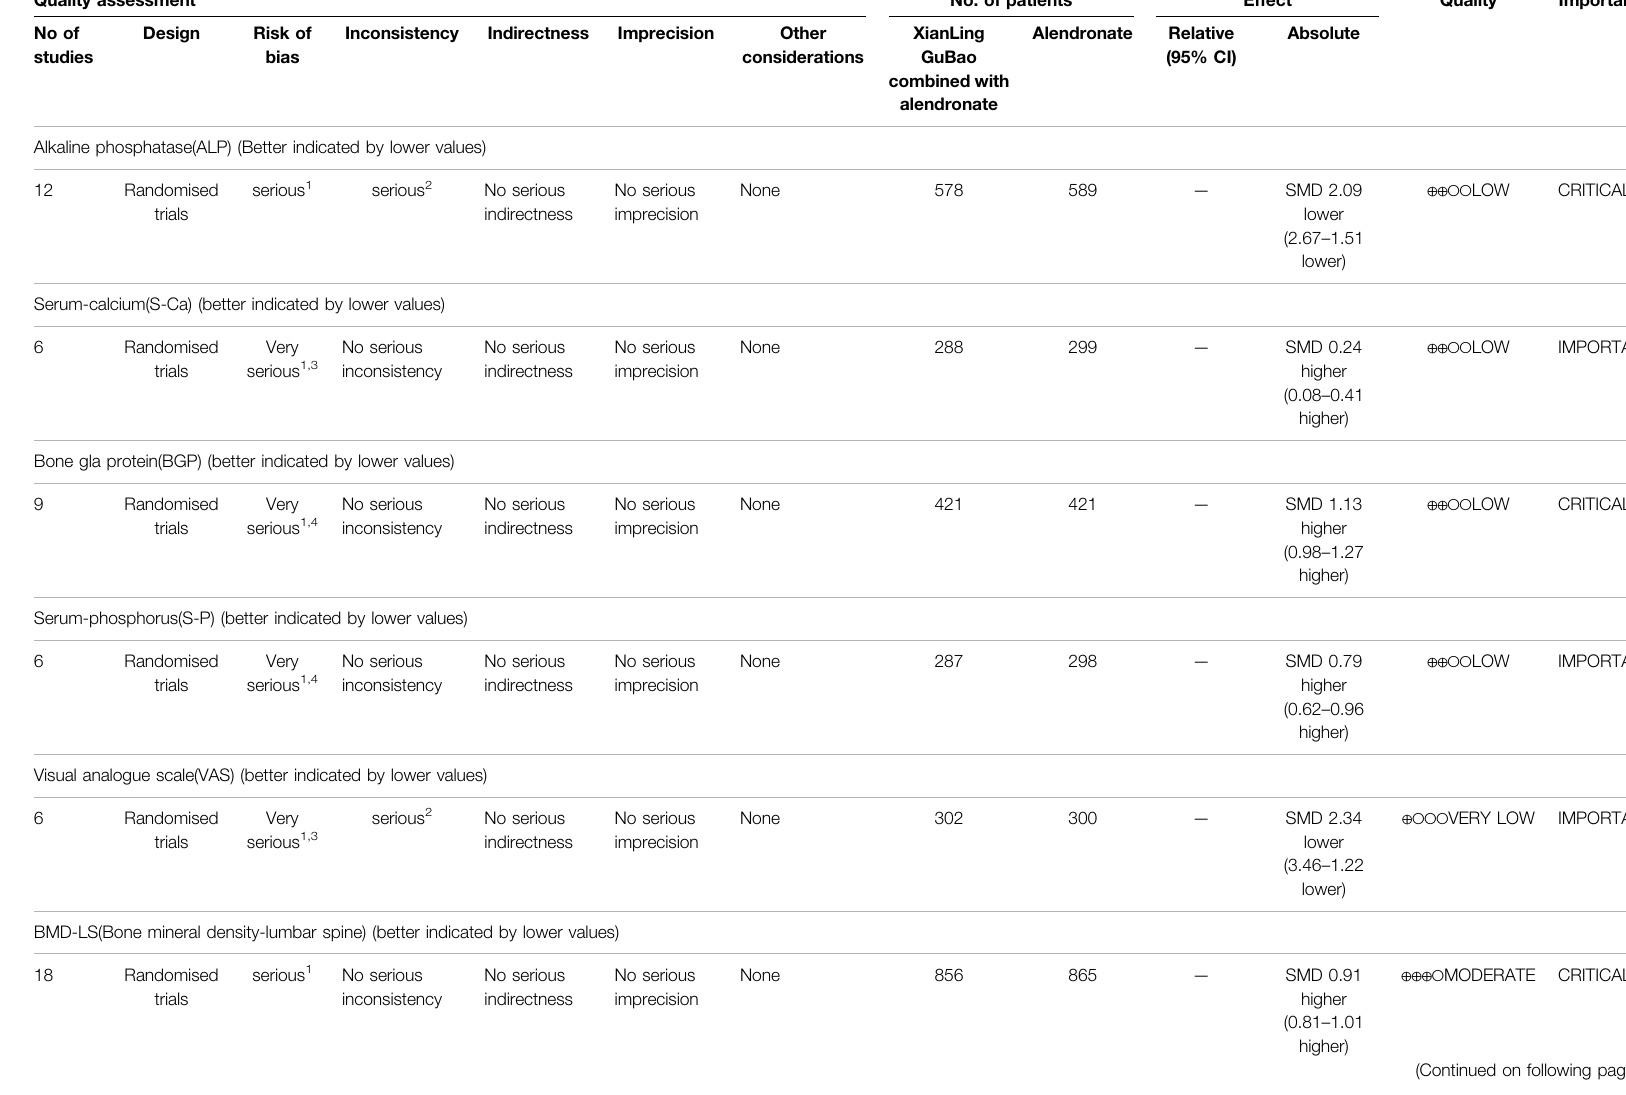
TABLE 4 | GRADE evidence pro fi